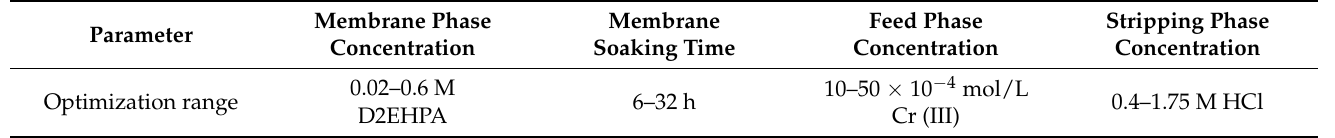
Table 1. The concentrations of various components for the optimization of parameters in SLM. Membrane Phase Parameter Concentration Optimization